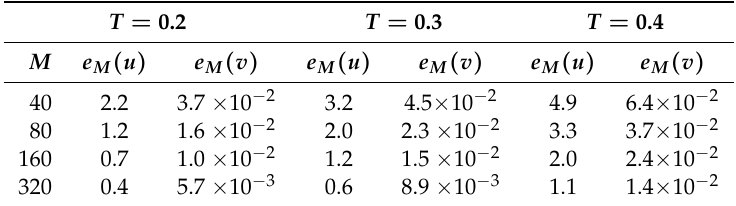
Figure 4. Scenario 2.0: accuracy test. Numerical approximations at simulated time T = 0.2 and T = 0.4 obtained with the S-LIMEX scheme with ∆ x = 80/ M and M = 160 and M = 640 (which correspond to the reference solution for computation of approximate errors in Table 1). Table 1. Scenario 2.0: Approximate L 1 errors e M ( u ) and e M ( v ) for Strang LIMEX method with ∆ x = 80/ M . Reference solution computed with M = 640.